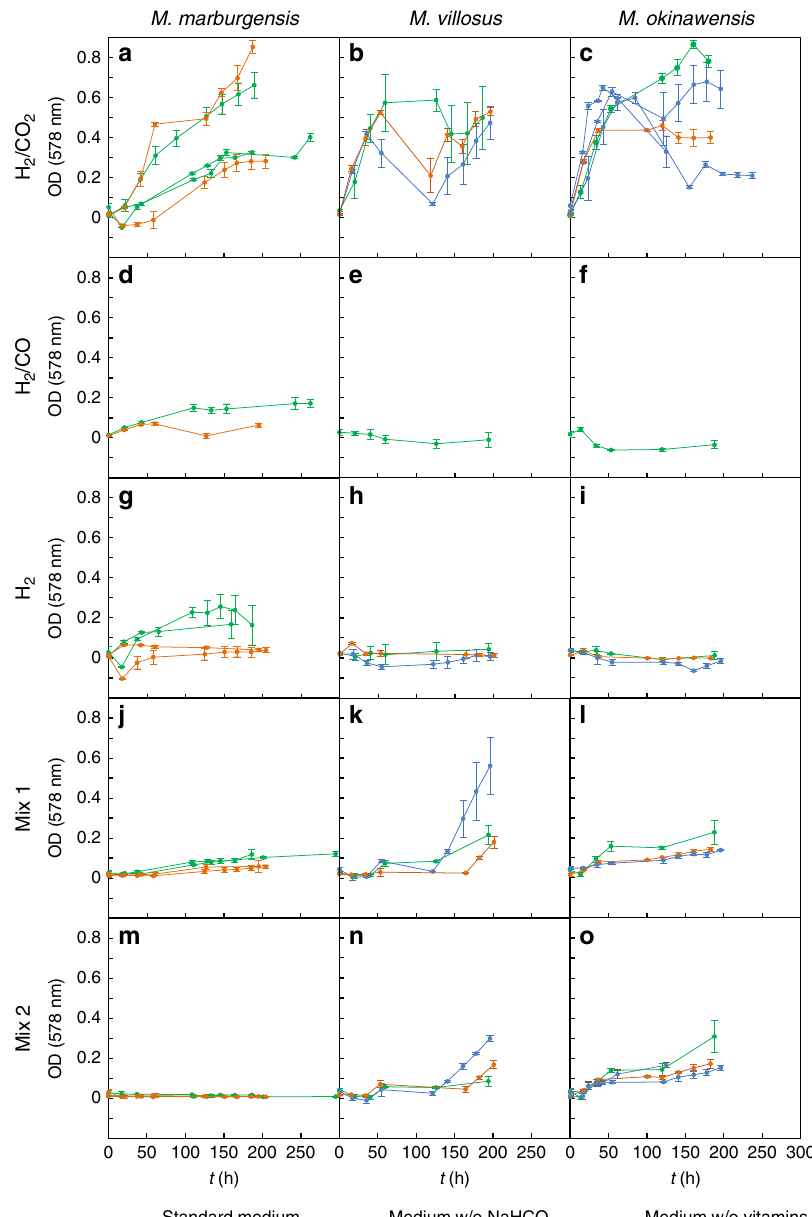
Fig. 1 In fl uence of the different headspace gas compositions on growth of M. marburgensis , M. villosus , and M. okinawensis . The error bars show standard deviations calculated from triplicates. OD curves of a , d , g , j , m M. marburgensis , b , e , h , k , n M. villosus and c , f , i , l , o M. marburgensis for a – c H 2 /CO 2 , d – f H 2 /CO, g – i H 2 , j – l Mix 1, and m – o Mix 2. Growth of M. marburgensis was inhibited by the presence of C 2 H 4 (see Table 2 for detailed gas composition). Only M. marburgensis seemed to be able to use sodium hydrogen carbonate (supplied in the medium) as C-source in case of a lack of CO 2 (H 2 or H 2 /CO as sole gas in the headspace). Both, M. villosus and M. okinawensis showed growth when Mix 1 and Mix 2 were applied to the serum bottle headspace; however, M. villosus exhibited extended lag phases. The dips in the graphs b , c were caused by substrate limitation due to depletion of serum bottle headspace of H 2